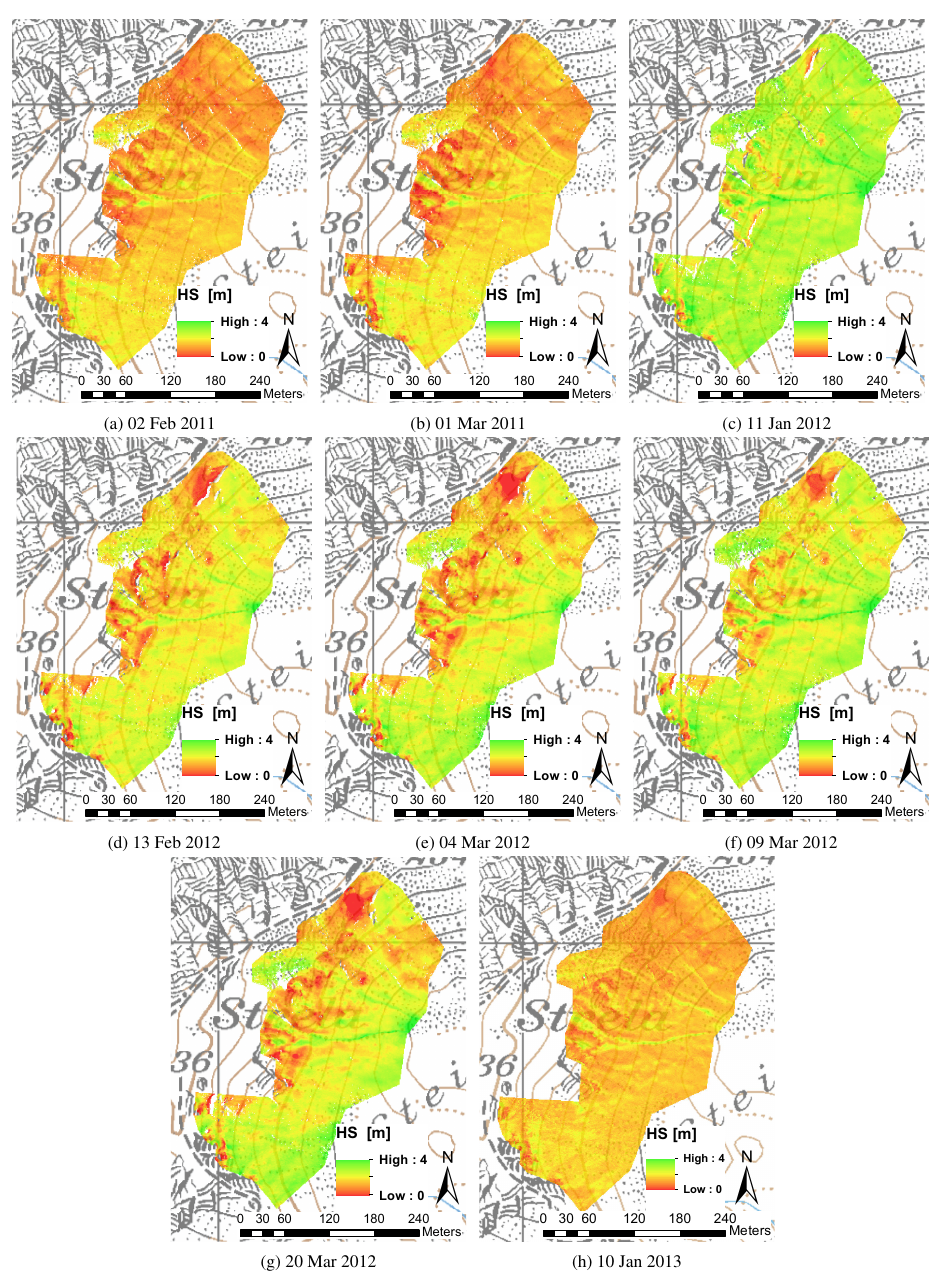
Fig. A4. Snow depth distributions in the basin ST. Pixmaps © 2013 swisstopo (5704 000 000). Fig. A4: Snow depth distributions in the basin ST. Pixmaps© 2013 swisstopo (5704 000 000).